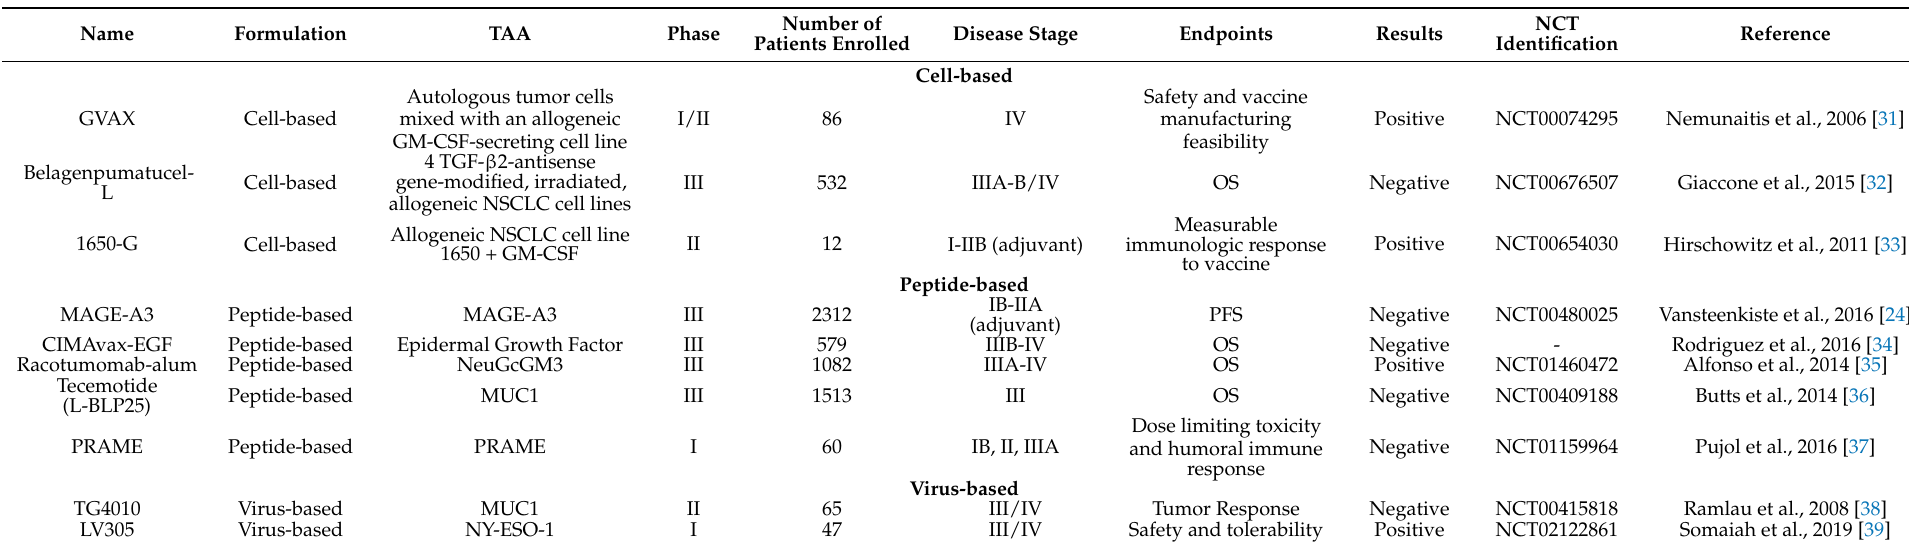
Table 1. Clinical trials of NSCLC vaccines encoding